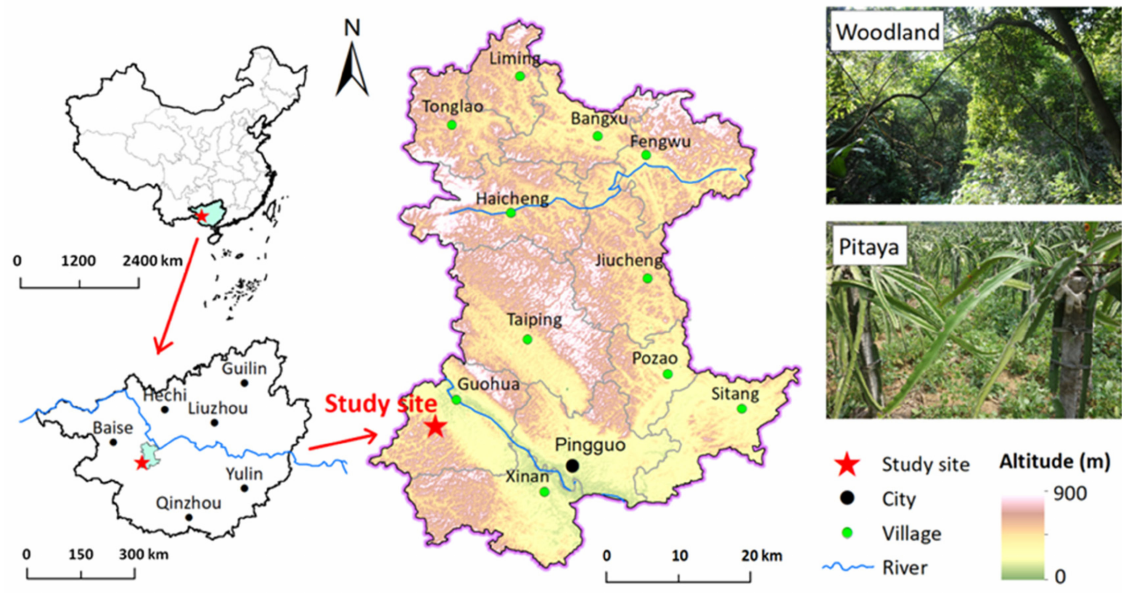
Figure 1. Schematic diagram of the study site.